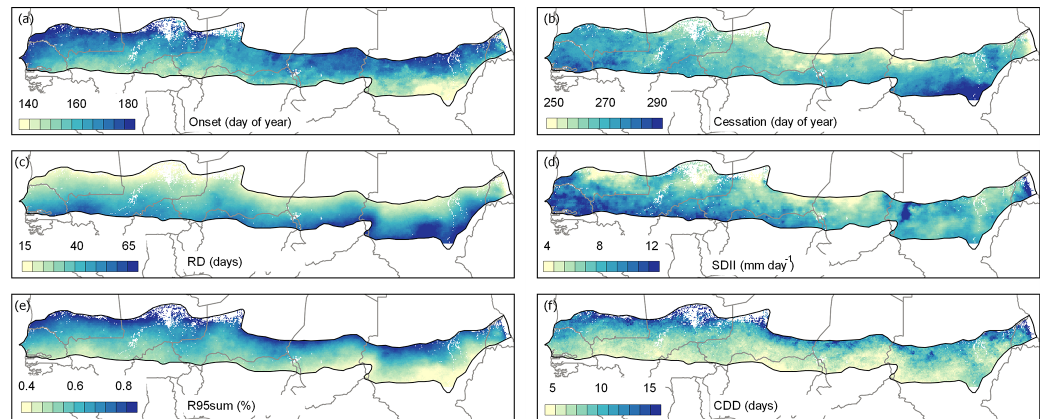
Figure 3. Spatial distribution of average seasonal-rainfall metrics: (a) onset of wet season (day of year); (b) cessation of wet season (day of year); (c) rainy days (days); (d) daily intensity (mmday − 1 ); (e) heavy-rainfall events (%); (f) consecutive dry days (days) based on 15-year averages (2001–2015). Pixels within the study area are masked (white colour) in accordance with the description in the methods section.